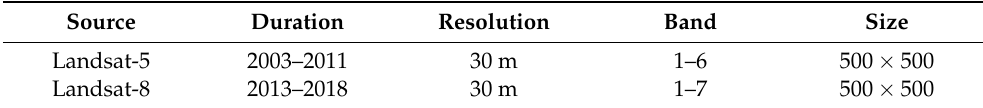
Table 1. Experiment data